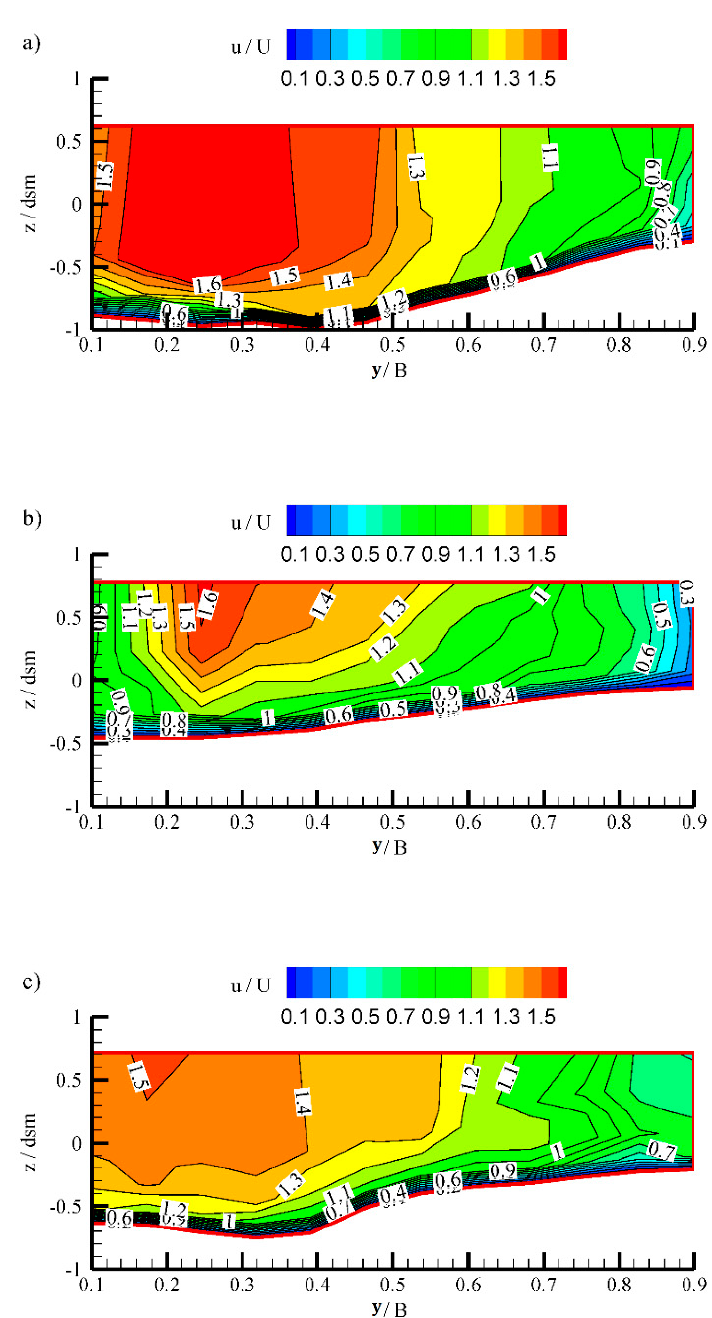
Figure 11. Streamwise velocity isolines at the bend apex: ( a ) Test 4 (without cylindrical rods), ( b ) Test 5 (Model SR) and ( c ) Test 6 (Model DR).